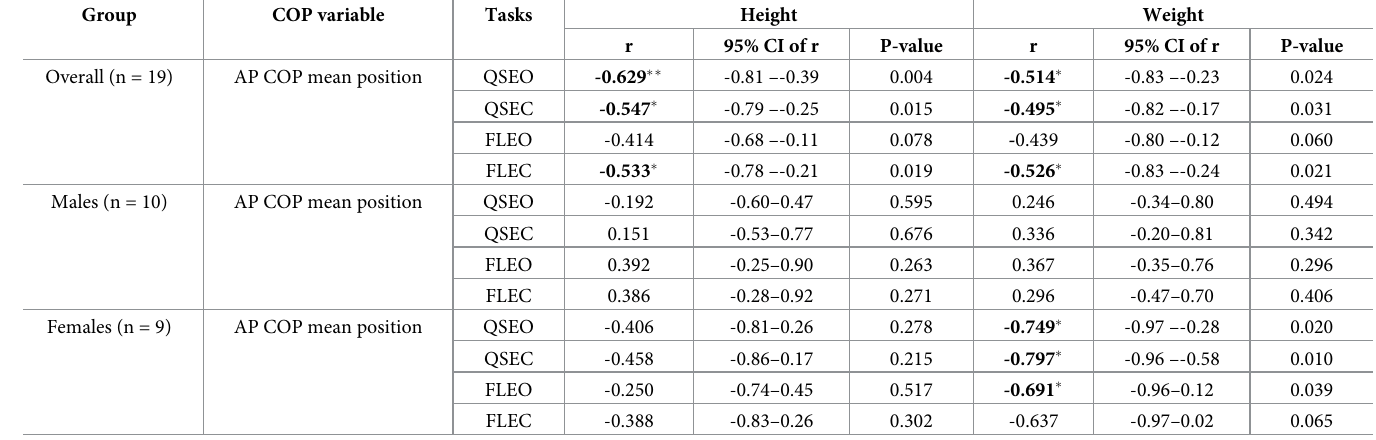
Table 2. Results of Pearsons’ correlation analysis of mean AP COP position with body height and weight. Group